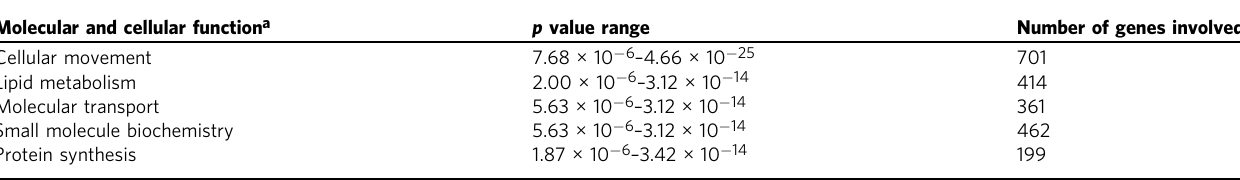
Table 1 Analysis of differentially expressed genes in Huh7 and Huh7- GCK + /HK2 − using gene set enrichment analysis (| FC | > 2 with a p value